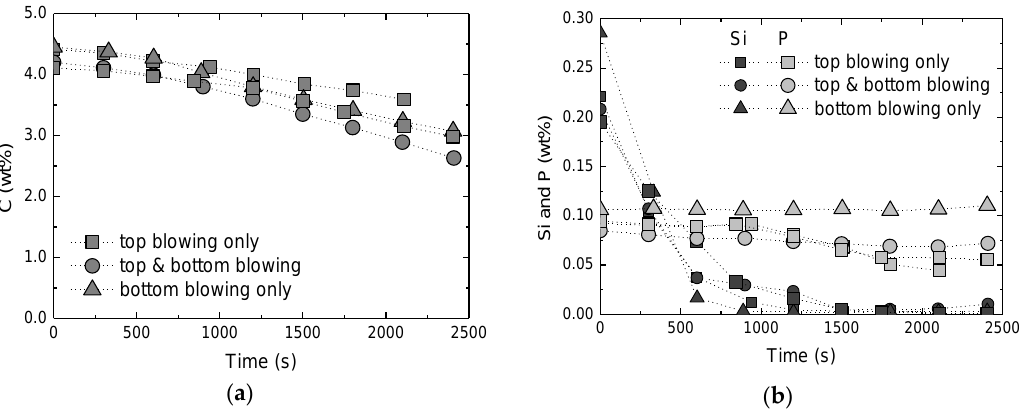
Figure 5. Changes in ( a ) C and ( b ) Si/P contents of hot metal with different supply methods of gaseous oxygen.